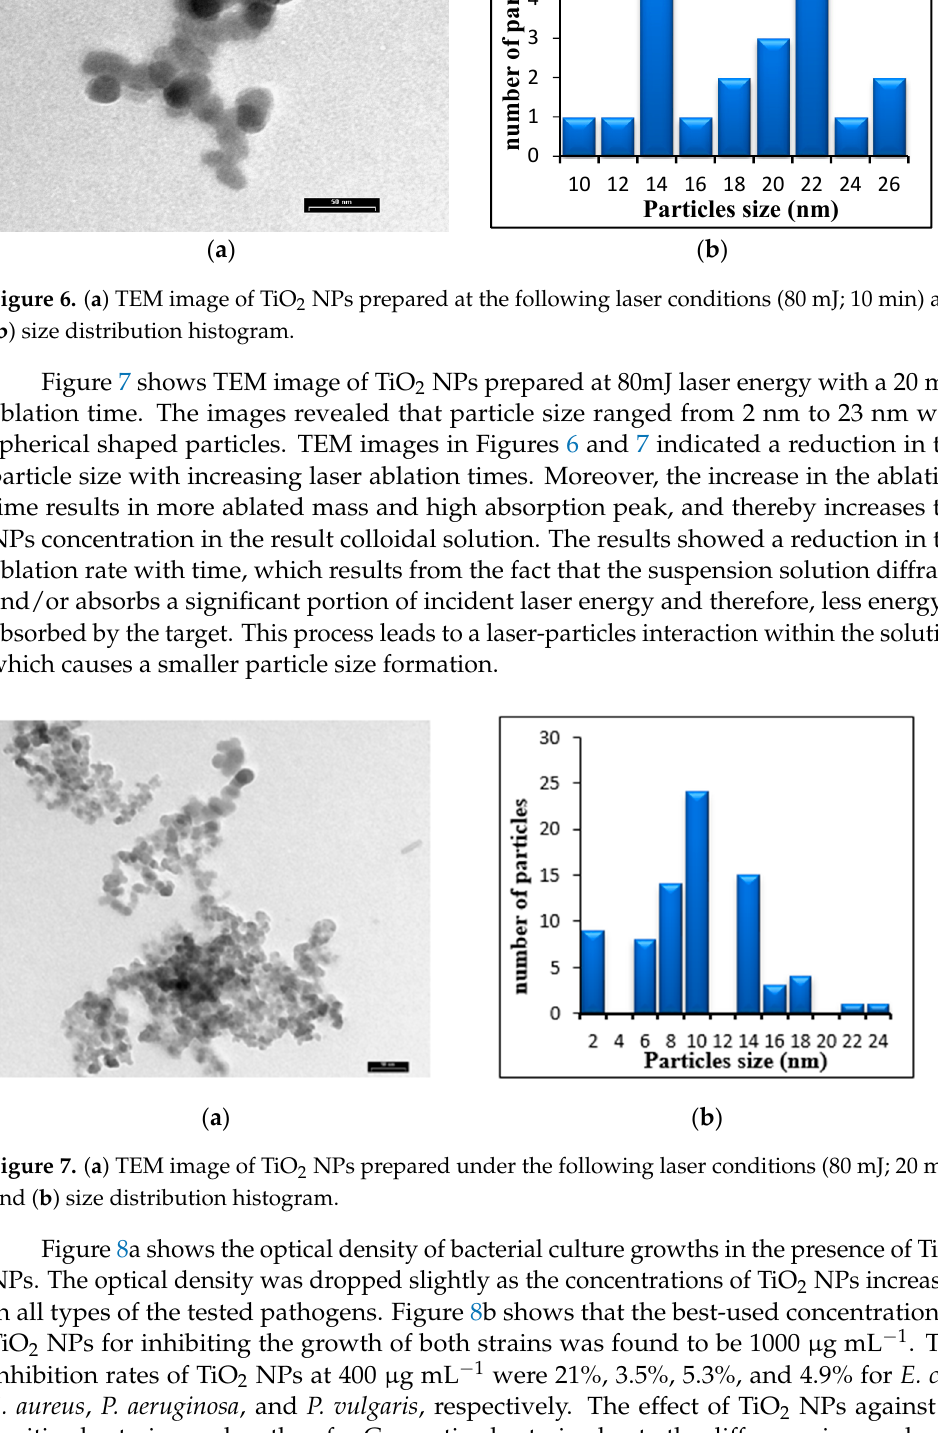
min) and ( b ) size distribution